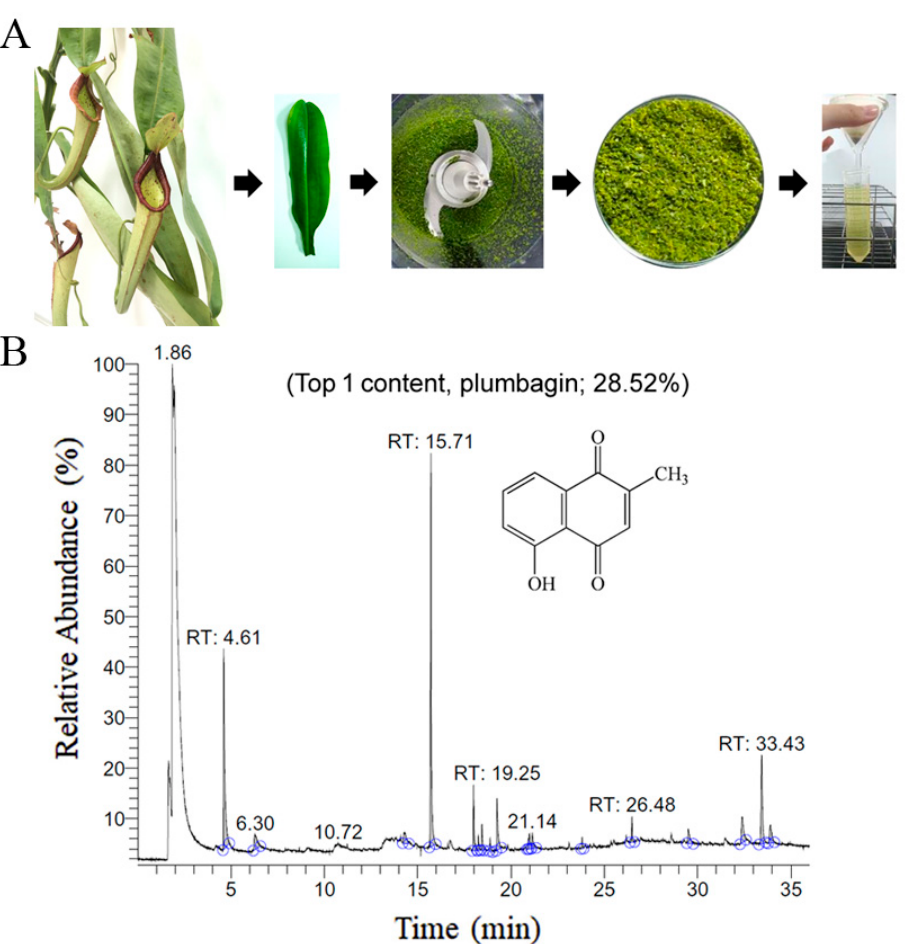
Figure 3. GC–MS analysis of N. miranda -leaf-acetone. ( A ) Preparation of the leaves extract. ( B ) GC chromatogram of compounds presents in N. miranda -leaf-acetone. Compounds were identified by matching generated spectra with NIST 2011 and Wiley 10th edition mass spectral libraries. Plumbagin (28.52%) was the major compound present in N. miranda Table 3. GC-MS analysis of N. miranda -leaf-acetone.